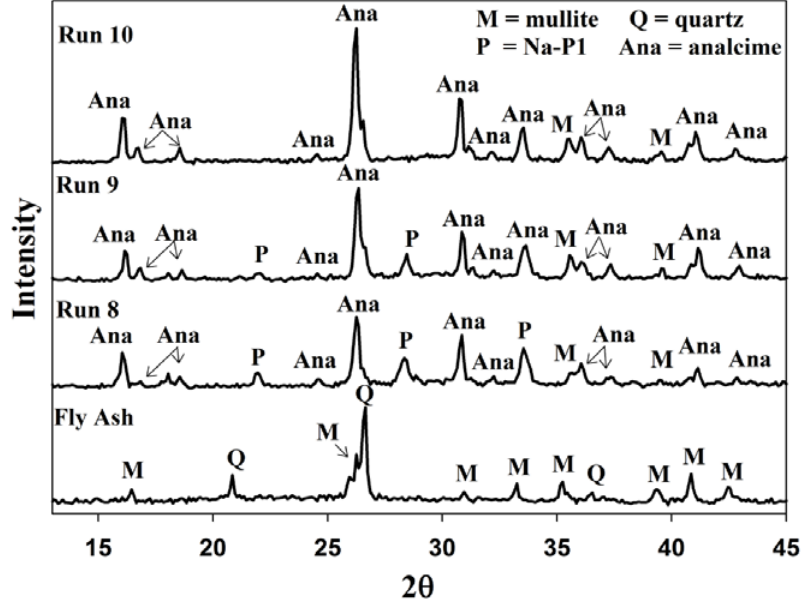
Figure 9. Powder X-ray diffraction patterns of products obtained after synthesis with supernatant waste as NaOH source using the amended synthesis approach. Run 8 Baseline run using fresh NaOH solution. Run 9 synthesis using waste supernatant from Run 8 as NaOH source. Run 10 synthesis using supernatant waste from Run 9 as NaOH